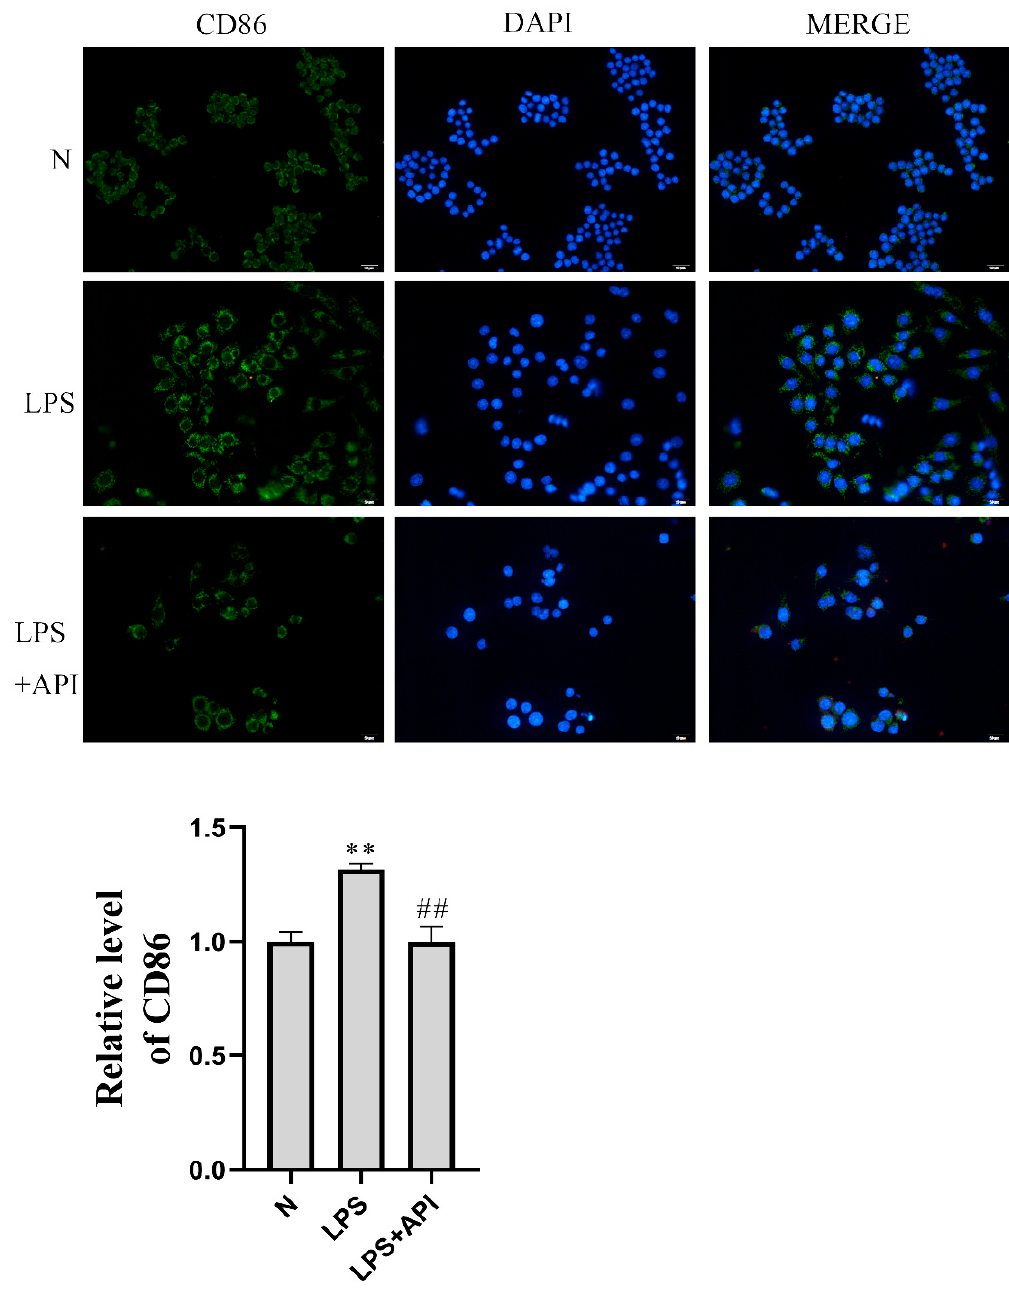
Figure 4. Apigenin inhibited macrophage M1 polarization. Above are representative immunoflu- orescence pictures of CD86 (magnification, × 200), The blue fluorescence is DAPI and the green fluorescence is CD86. Compared with group N, the median fluorescence intensity (MFI) of CD86 in the LPS group was significantly increased. Apigenin significantly reduced the expression level of the CD86 protein. The figure below shows the quantitative fluorescence intensity of CD86-positive cells: ** p < 0.01 versus normal group (N); ## p < 0.01 versus LPS group.